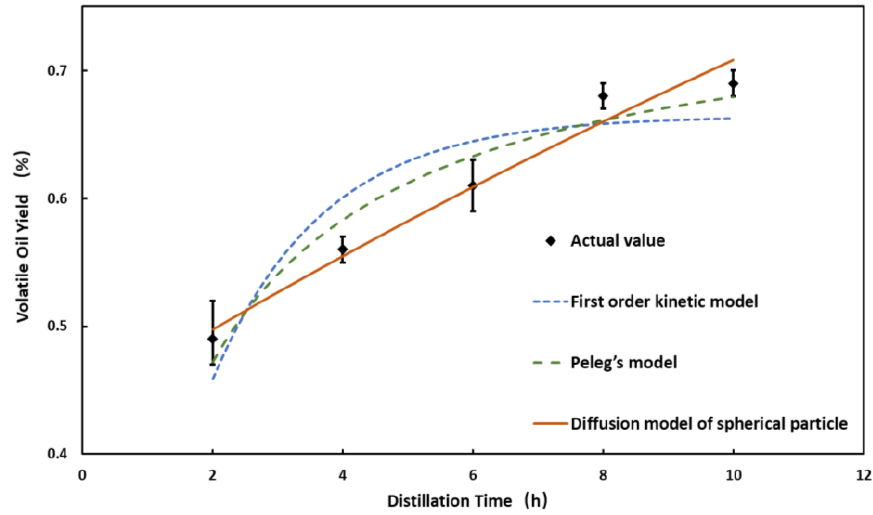
Figure 3. The effect of distillation time on the volatile oil yield ( n = 3).